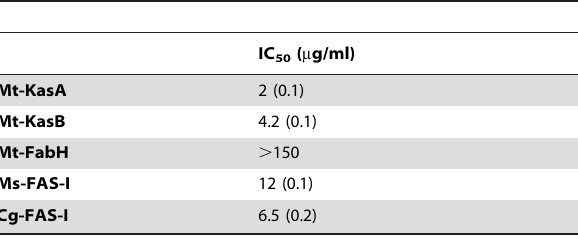
Table 2. In vitro inhibition (IC 50 ) of platensimycin against Mt- KasA, Mt-KasB, Mt-FabH and Ms-FAS-I and Cg-FAS-I.